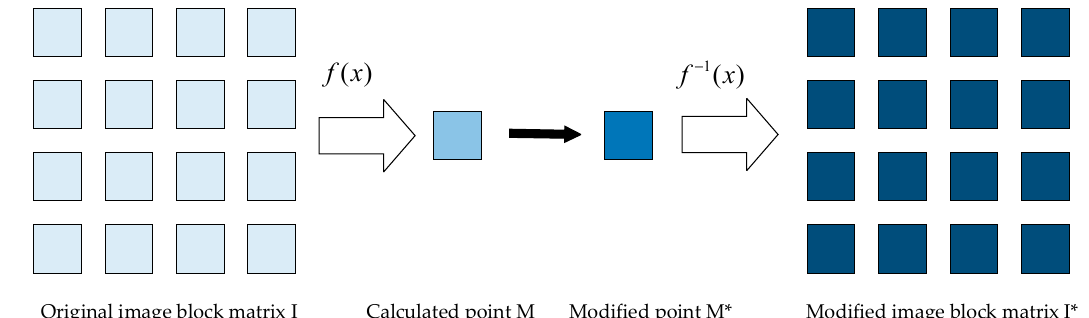
Figure 3. The process of changing the unit module.